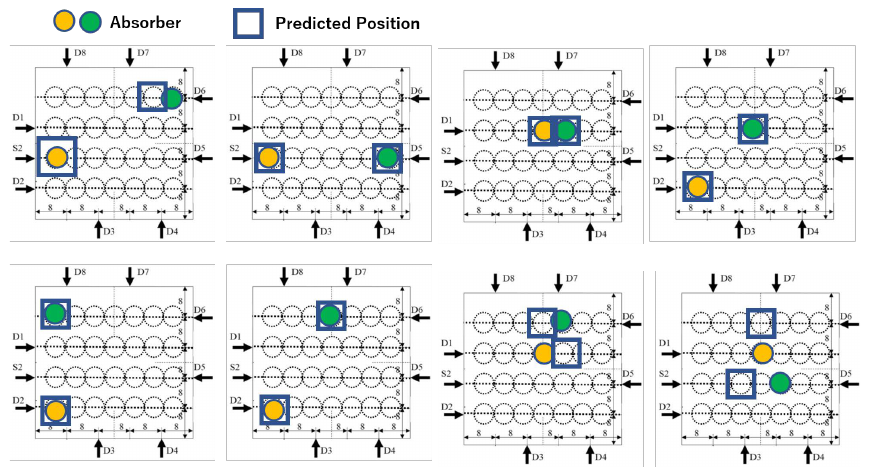
Figure 7. Example results for two absorbers. Orange and green circles are absorbers, and predicted positions are indicated by blue